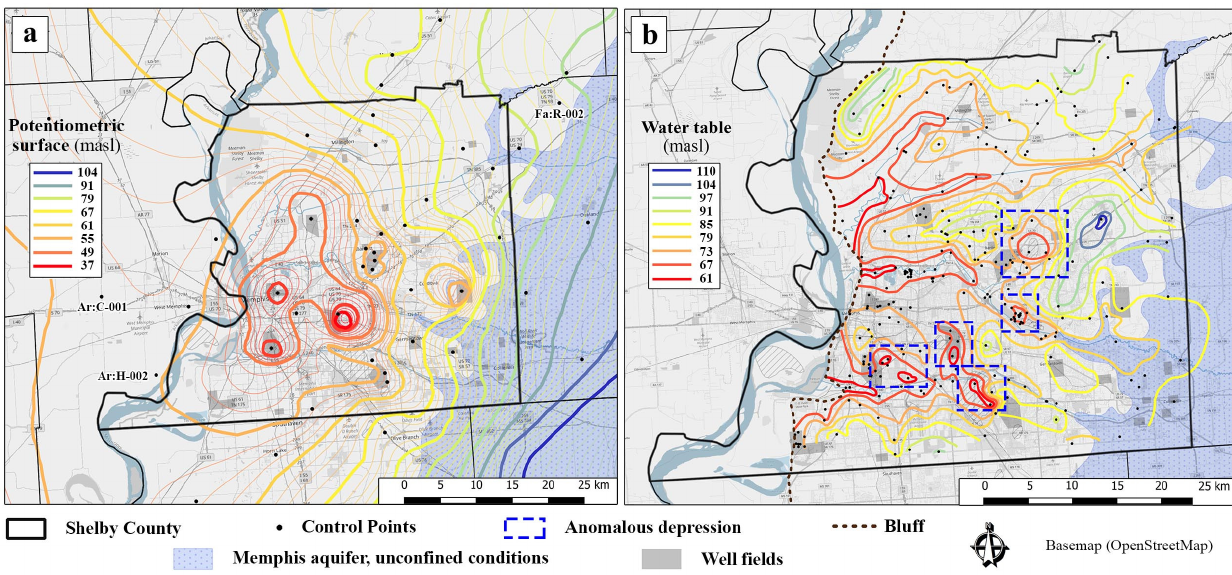
Figure 2. ( a ) Regional potentiometric surface in Spring of 2007 [48]. ( b ) Water table elevation map for the Fall of 2005 [41] displaying anomalous depressions. The bluff forms the transition between the Mississippi Alluvial plain and Gulf Coastal plain [49].